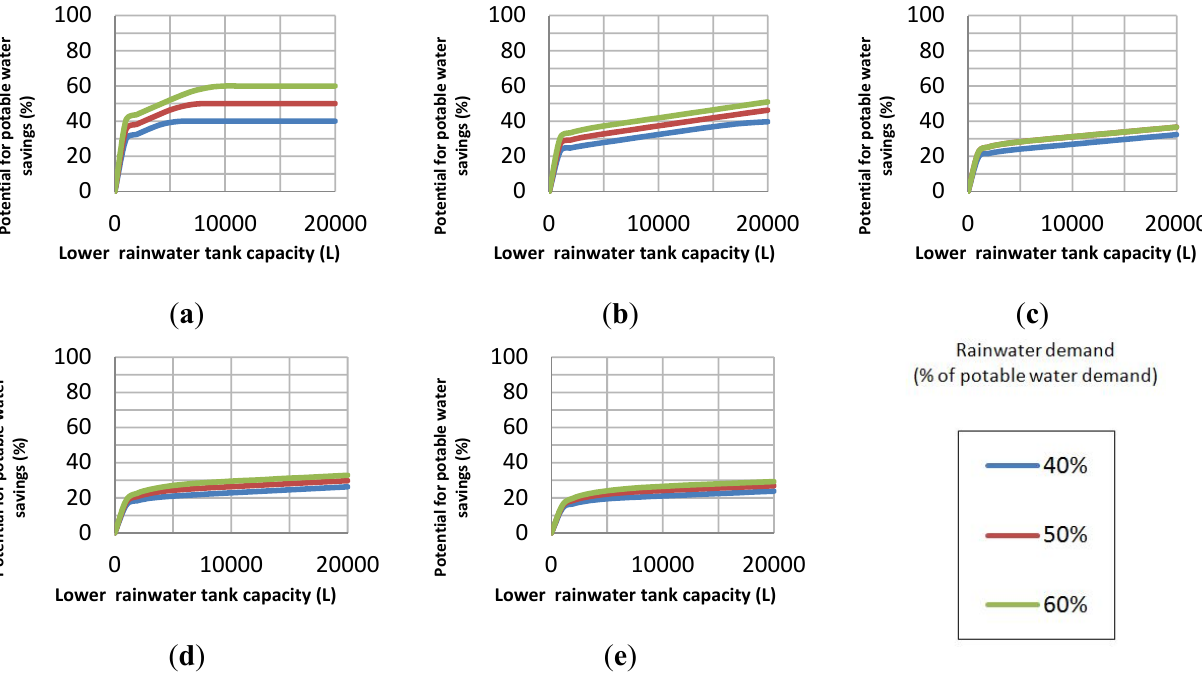
Figure 12. Potential for potable water savings as a function of lower rainwater tank capacity and potable water demand for Darwin, Australia, for a catchment area of 100 m 2 and different potable water demands. ( a ) 100 L per house per day; ( b ) 300 L per house per